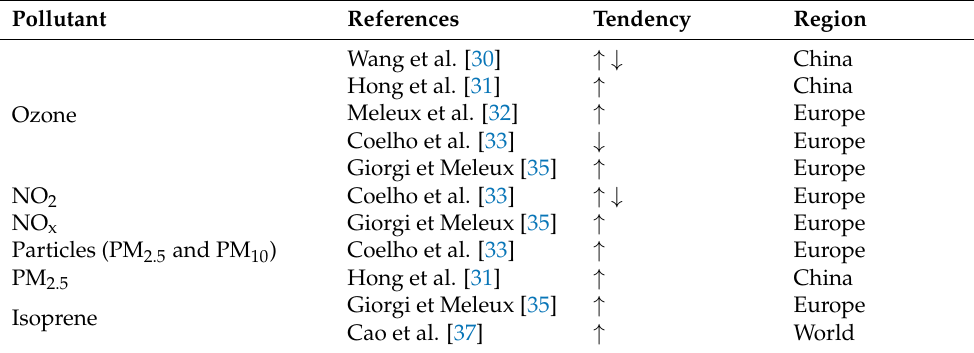
Table 4. Predicted trends in outdoor pollutant concentrations under future climate conditions. ↑ : increase, ↓ : decrease, ↑ ↓ : increase in some geographical zones and decrease in